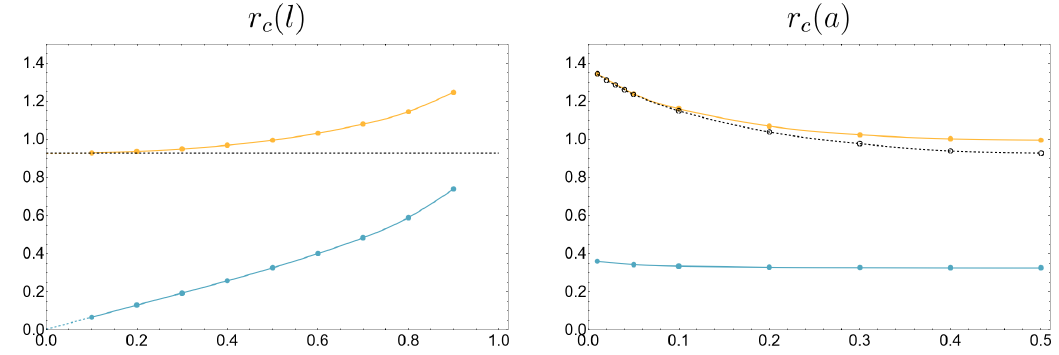
Figure 7. Critical radius as a function of the modulus l (left, a = 1 / 2 ) and of the coupling a (right, l = 1 / 2 ). Results for the standard bosonic, elliptic fermionic and elliptic bosonic sinh- Gordon models are shown in dashed black and solid blue and orange, respectively. On the left panel the colored dashed lines show extrapolations for l → 0 : the fermionic case linearly approaches r c ( l = 0) = 0 , whereas the bosonic case has r c ( l ) = r c ( l = 0) + l 2 with r c ( l = 0) ≈ 0 . 995 , 4(1 − l ) 1 / 5 which fits all the datapoints and matches at l = 0 the critical radius obtained for the bosonic sinh-Gordon model. On the right panel, the critical radii of the bosonic standard and elliptic sinh- Gordon models are very similar for small a , displaying more significant differences as a ≈ 1 / 2 , while staying always above the critical radius of the fermionic elliptic